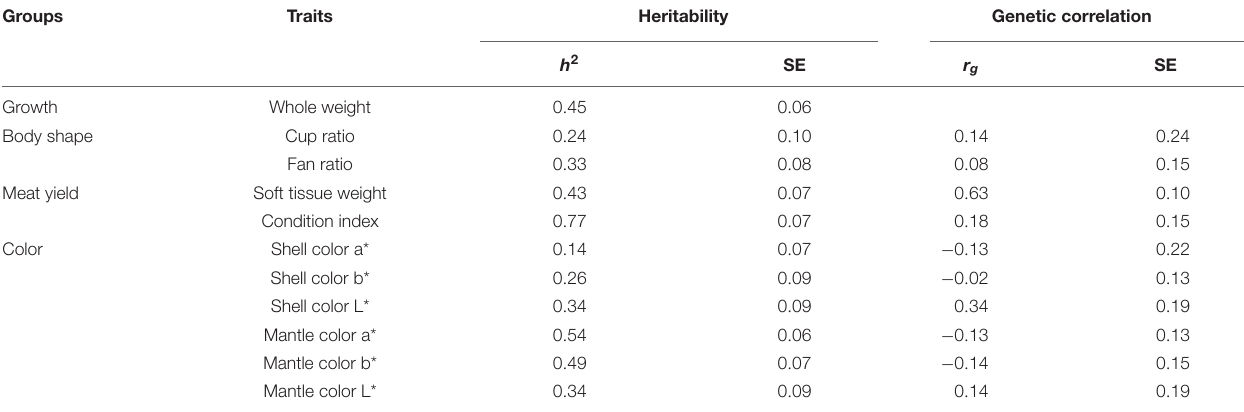
TABLE 2 | SNP heritability ( h 2 ) and genetic correlations ( r g ) of whole weight with other traits. Groups